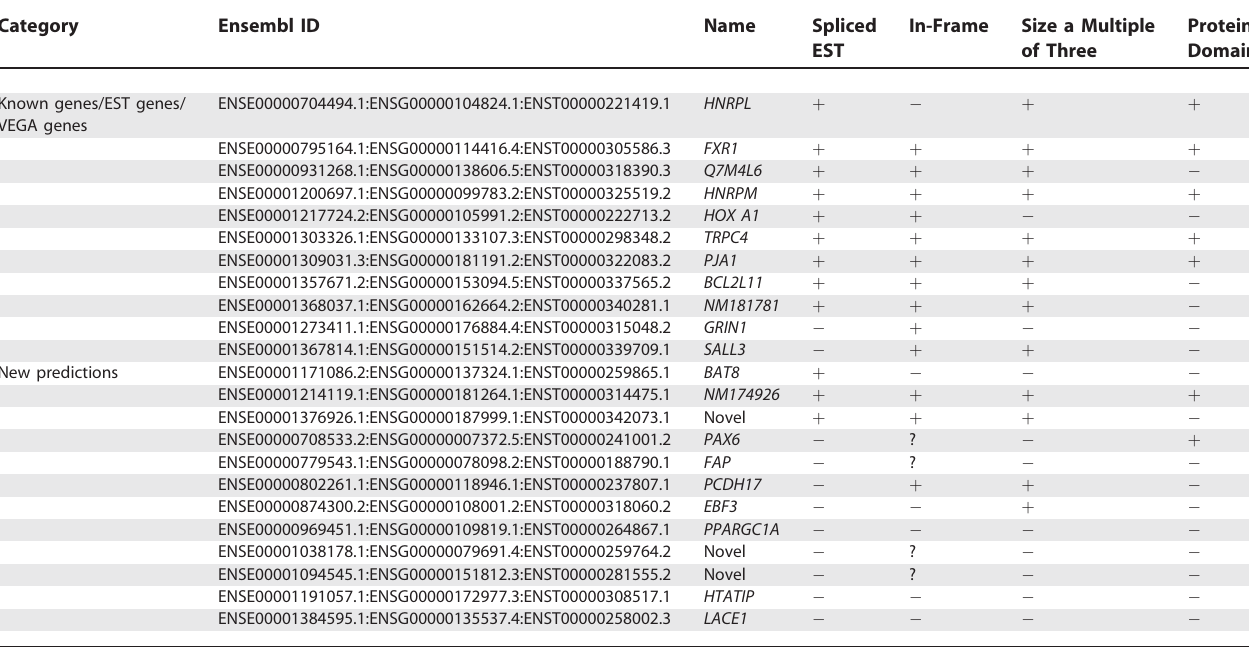
Table 2. Predicted Conserved Coding IREs and Their